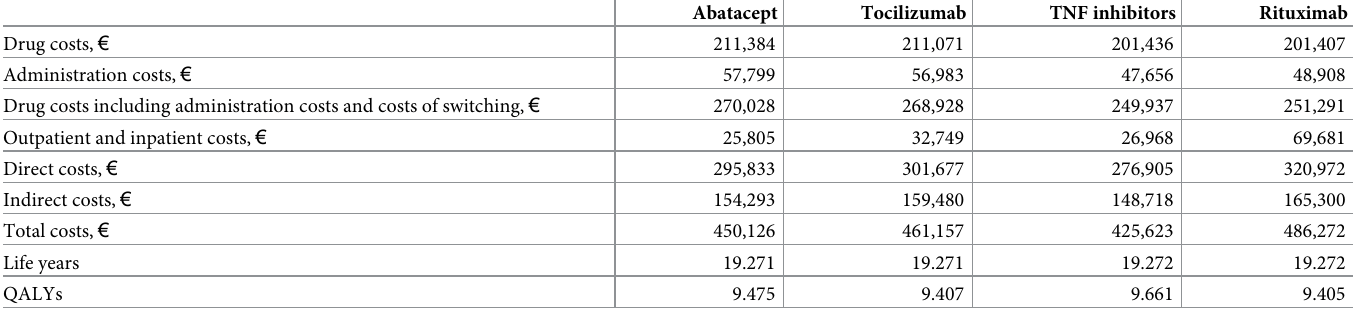
Table 2. Lifetime costs and QALYs of bDMARDs per patient as a second-line biologic therapy in rheumatoid arthritis. All costs and QALYs were discounted at 3% per year.